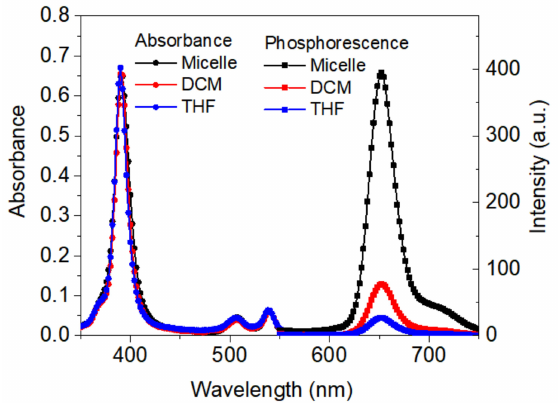
Figure 4. Photophysical properties of PtTFPP in micelles, tetrahydrofuran (THF), and dichloromethane (DCM)